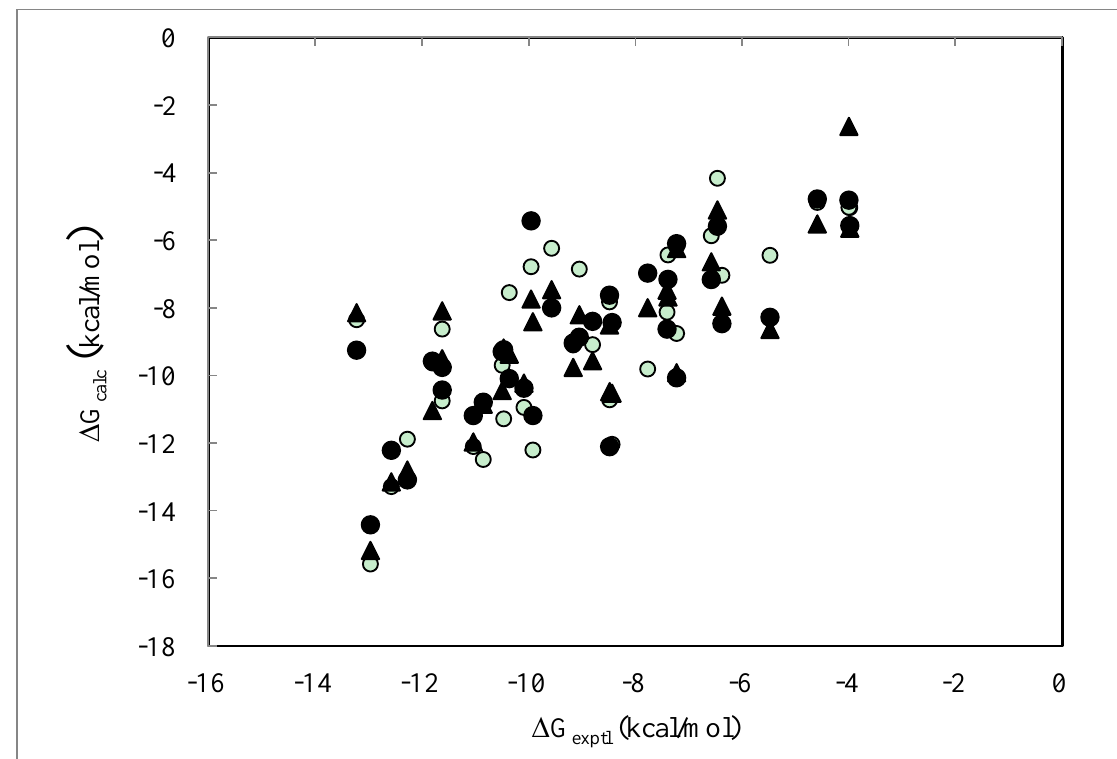
Figure 1. Cross-validation results obtained by the DIAV, DIAV_LW and DIAV_LC methods: The experimental data (  G ) and the calculated values (  G ). Open circles, filled circles exptl calc and filled triangles represent the results obtained by the DIAV, DIAV_LW and DIAV_LC methods,